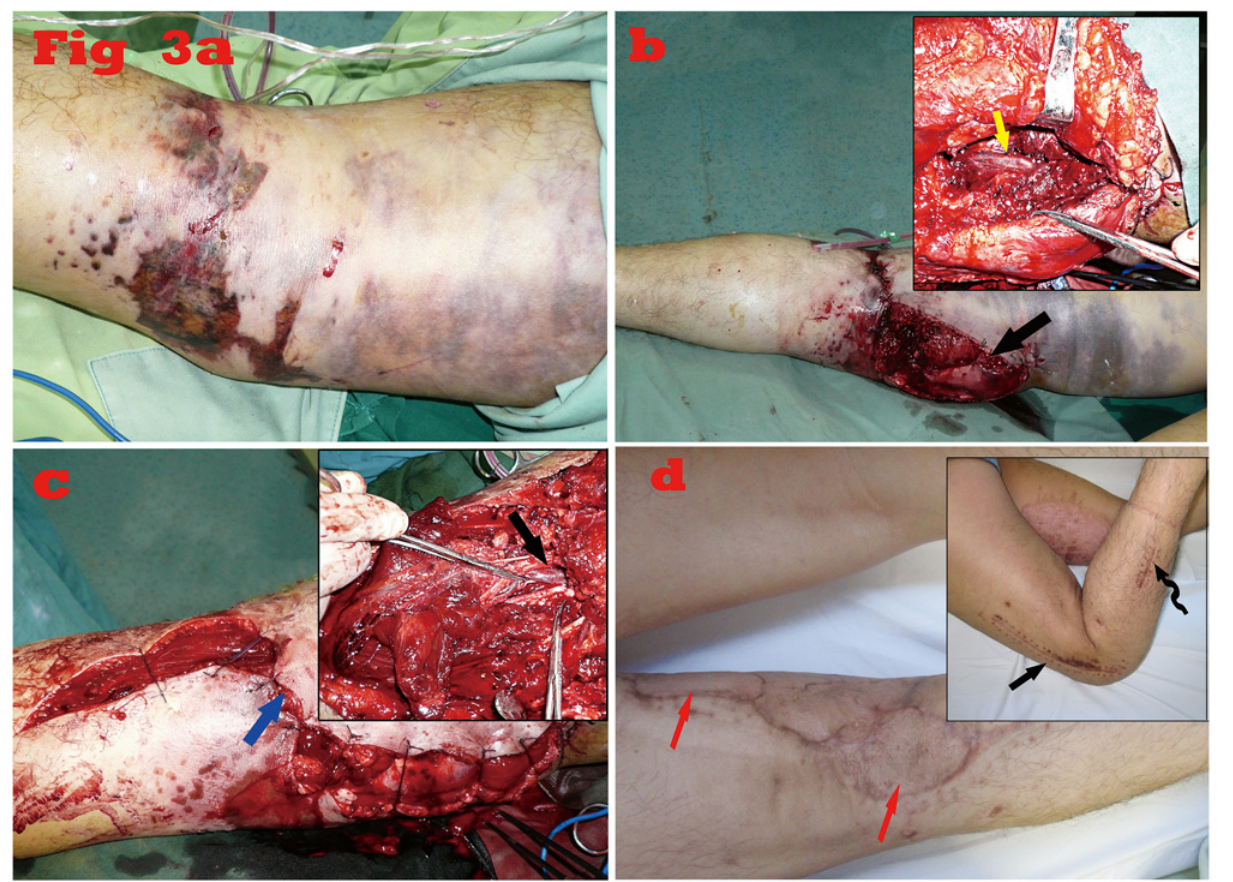
Fig 3. A representative case. a. Preoperative view. The straight arrow indicates the popliteal fossa and the curved one indicates the medial femoral condyle. b. Intraoperative view during primary exploration. The yellow arrow on the top in the inset shows the appearance of the injured femoral artery; the black arrow on the bottom indicates the site of arterial injury. c. Intraoperative view during re-exploration. The black arrow on the top in the inset shows the appearance of the injured popliteal artery; the blue arrow on the bottom indicates the site of arterial injury. d. Postoperative view at 15-month follow-up. The black arrows on the top in the inset show the appearance of lateral incisions for fasciotomy and internal fixation of the femur fracture, respectively; the red arrows on the bottom show the sites of skin grafting for the coverage of wounds.